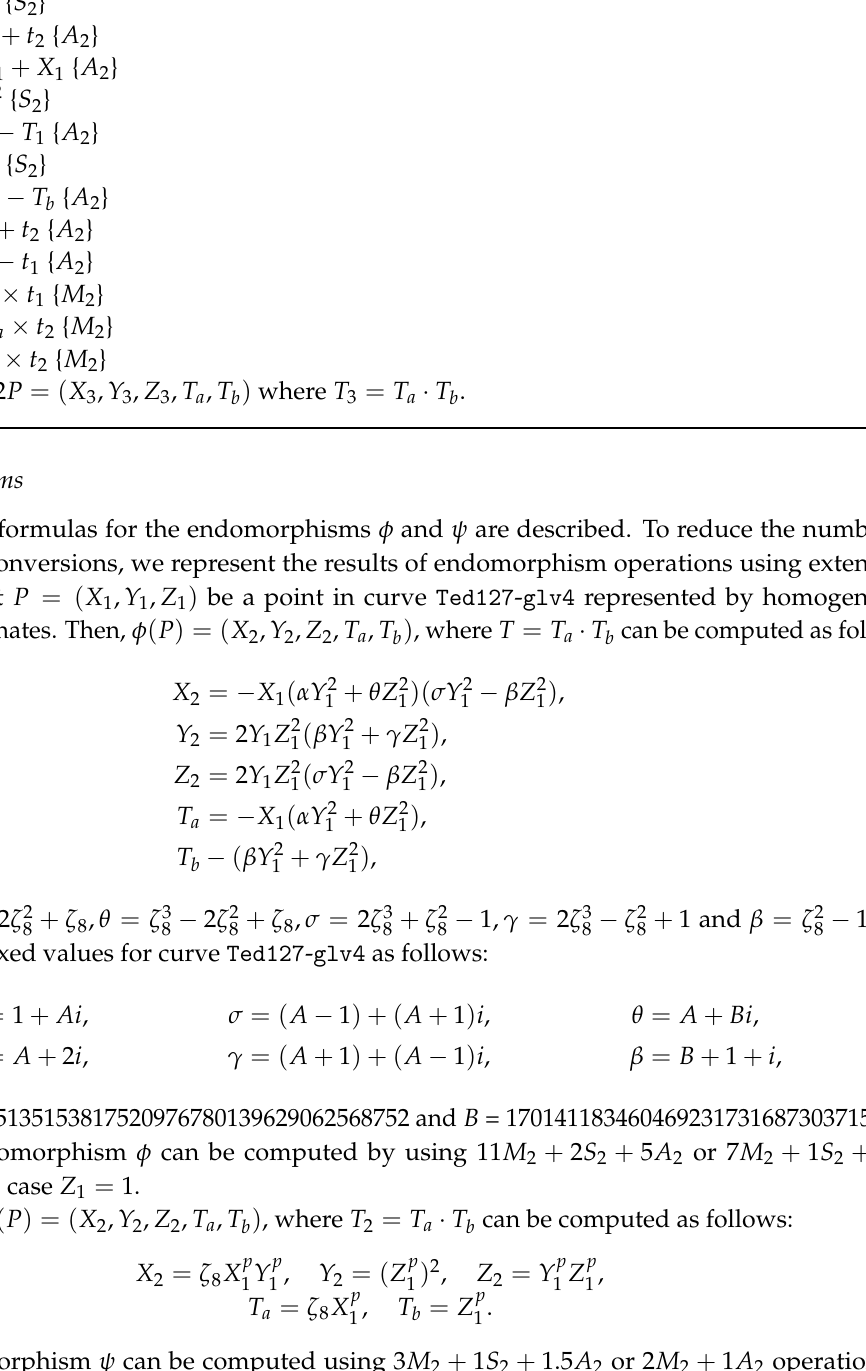
Algorithm 7: Twisted Edwards point doubling over F